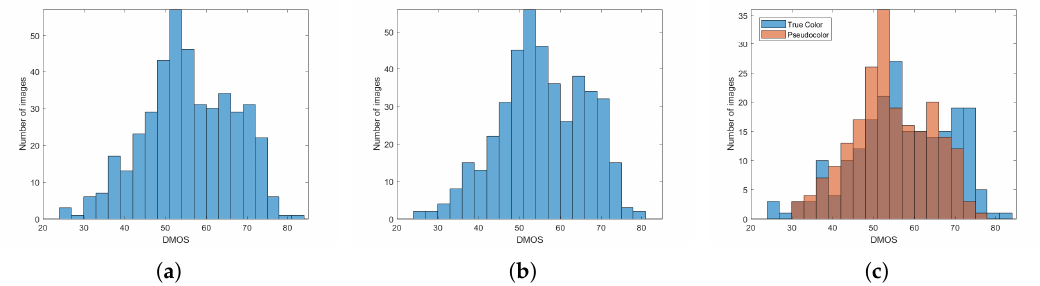
Figure 3. Histograms of the differential mean opinion scores (DMOS) in 33 equally-spaced bins for ( a ) scores obtained for all images before subject rejection, ( b ) scores obtained for all images after subject rejection, and ( c ) scores after subject rejection for true color and pseudo-color image representation in the subjective study.